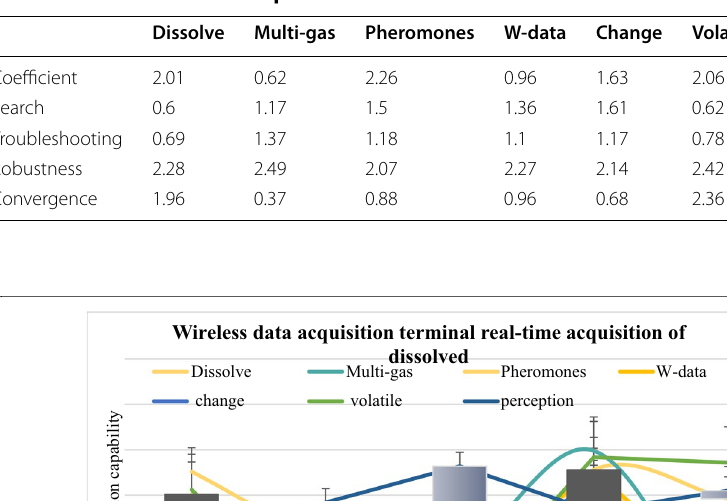
Table 6 Redundant test sample data